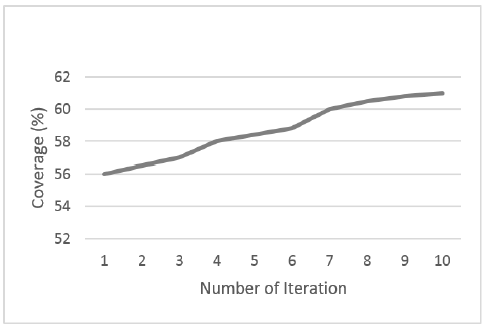
Figure 4: Coverage improvement over iterations for run number